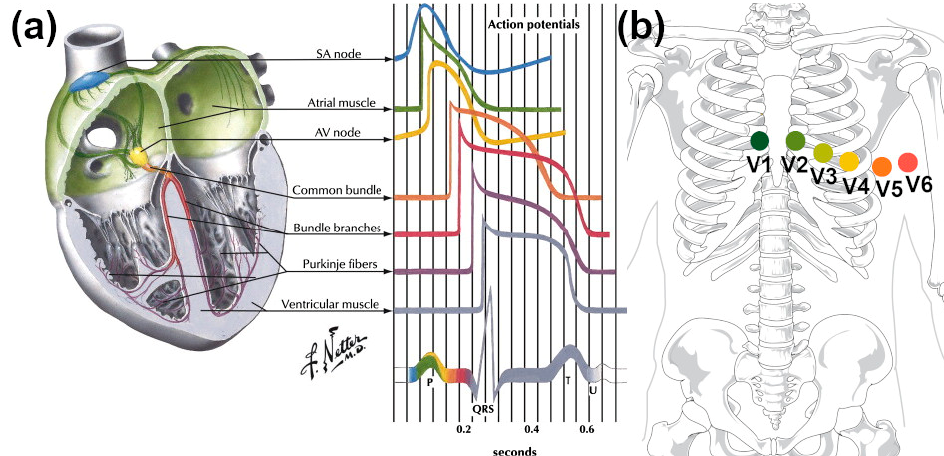
Figure 8. ( a ) Resolution of cardiac signals from individual activities of the heart reproduced with permission from [159], Copyright Elsevier (2014). ( b ) Correct placement of ECG electrodes at the following locations: V1 (4th intercostal space on the right sternum), V2 (4th intercostal space on the left sternum), V3 (equidistant between V2 and V4), V4 (5th intercostal space at the midclavicular line), V5 (anterior axillary line on the same horizontal level as V4), and V6 (mid-axillary line on the same horizontal level as V4 and V5) [160].